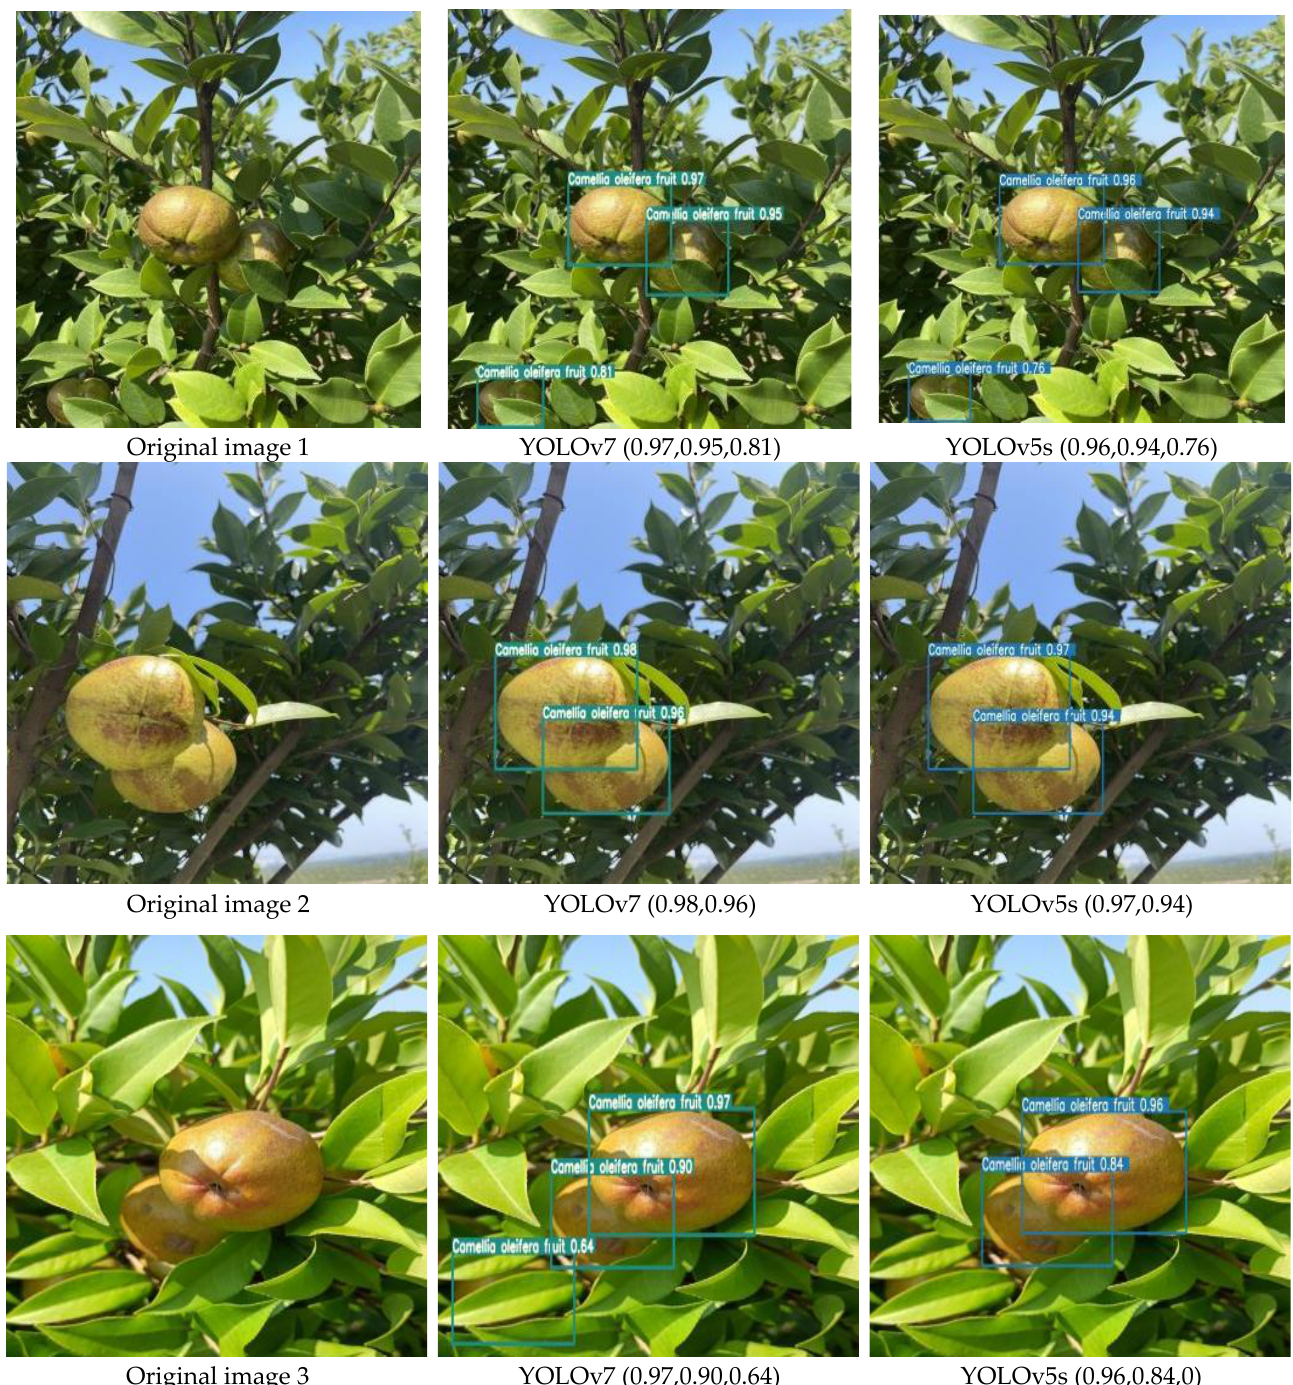
Figure 11. Comparison of detection results.